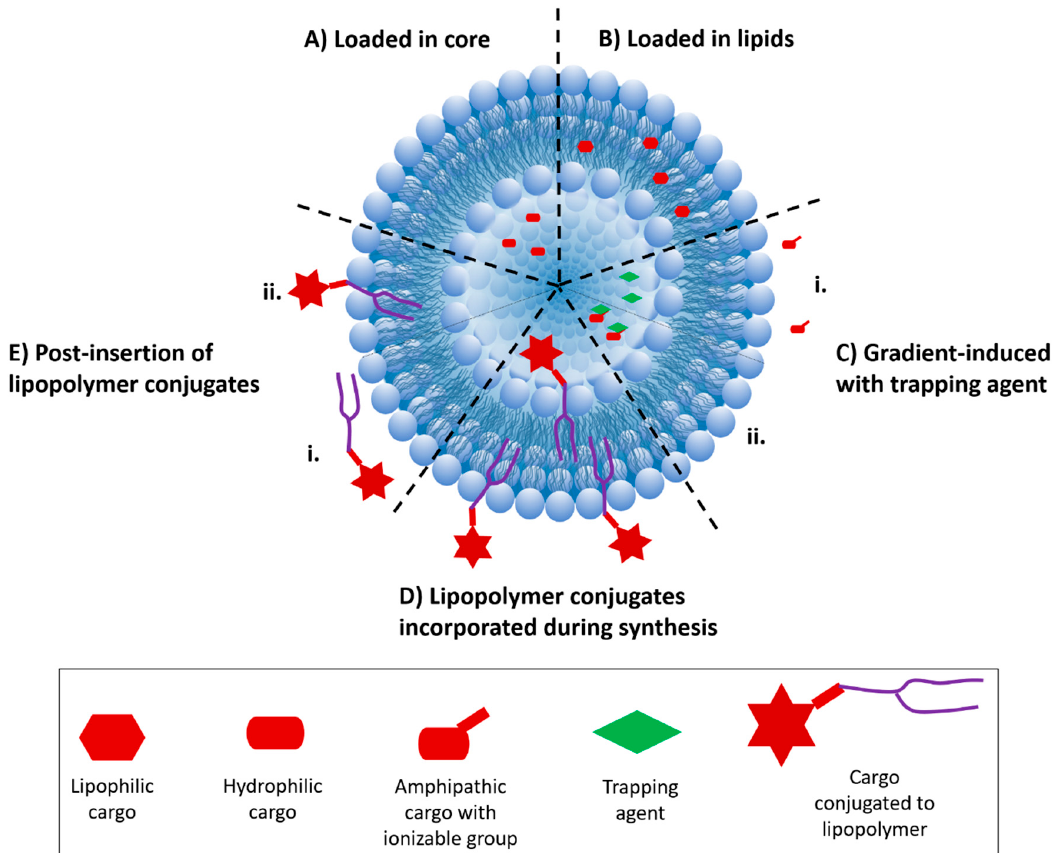
Figure 2. Various modes of liposomal drug incorporation. In passive loading, drugs can be incorporated into the nanoparticle (NP) during liposome synthesis. Depending on the drug’s properties, it can be loaded into ( A ) the hydrophilic core or into ( B ) the hydrophobic lipid bilayer. ( C ) In active loading, (i) drugs can be incorporated into the core of the liposome after NP synthesis by using pH or salt gradient, and (ii) after gradient-induced internalization, the drug forms a complex with the trapping agent (ions / salt) and remains sequestered in the core. ( D ) Liposomes comprised of drug-bearing lipopolymer conjugates displaying drugs on the surface and in the core are formed by incorporating the lipopolymer during NP synthesis. ( E ) Liposomes formed by post-insertion of the lipopolymer conjugate display the drug cargo on the NP surface.